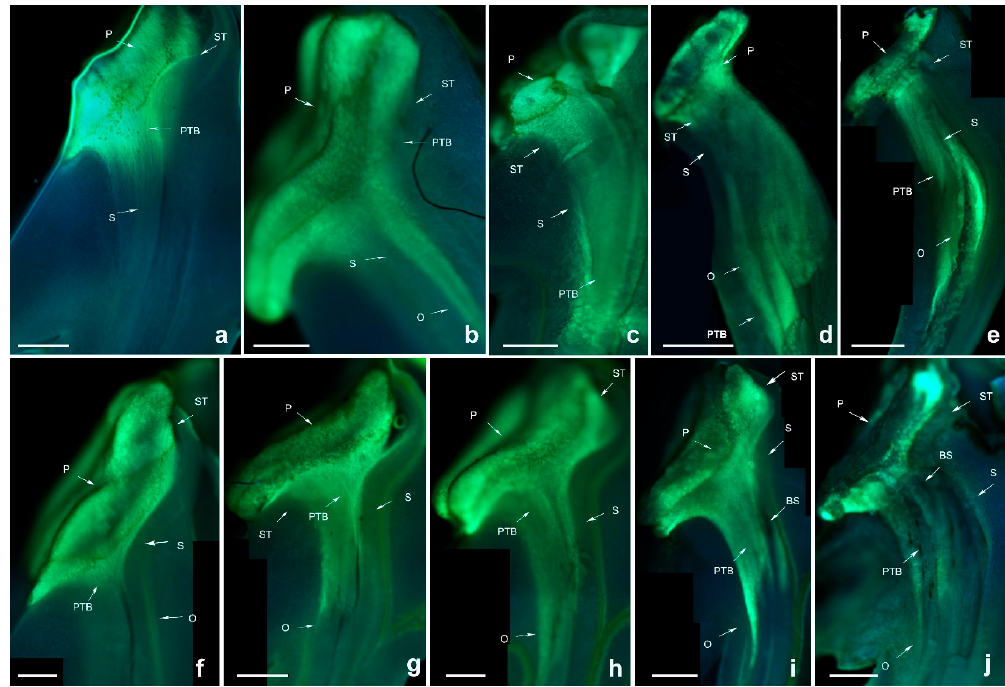
Figure 4. Growth of pollen tubes after self- and cross-pollination of Dendrobium denneanum. P: pollinium; ST: stigma. BS: black spots; PTB: pollen tube bundle; S: style; O: ovary. ( a ) 24 h after cross-pollination; ( b ) 48 h after cross-pollination; ( c ) 72 h after cross-pollination; ( d ) 96 h after cross-pollination; ( e ) 120 h after cross-pollination; ( f ) 24 h after self-pollination; ( g ) 48 h after self-pollination; ( h ) 72 h after self-pollination; ( i ) 96 h after self-pollination; ( j ) 120 h after self-pollination. Bars = 100 µm.